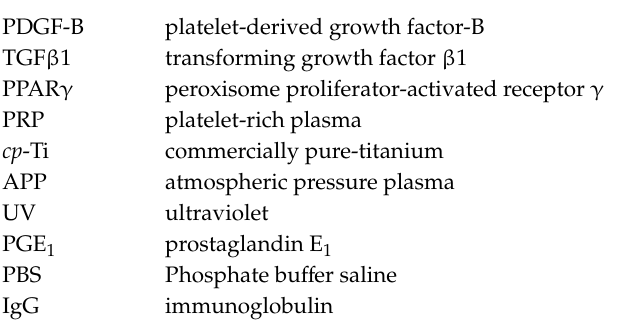
Figure S1: Analyses of immunofluorescence photomicrograph images of CD62P and other biomolecules (a: PPAR γ , b: PDGF-B, c: TGF β 1). Each photograph was separated into three RGB files and the individual regions or particles positive for CD62P or the biomolecules were expressed as total pixels. The ratio of each biomolecule to CD62P is expressed as a box plot. N =